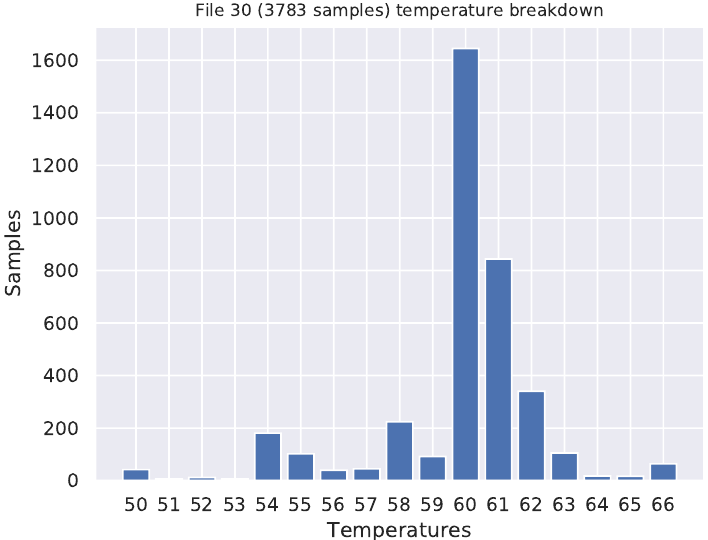
Figure 8. Example of the temperature distribution in a concrete data